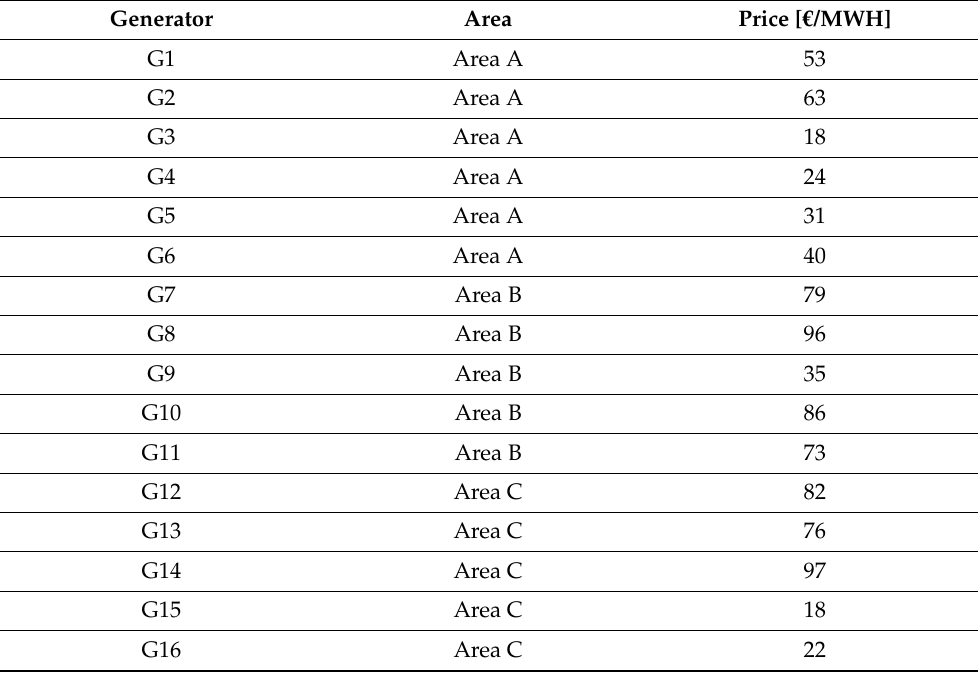
Table 1. Generator bids for the PST 16-machine test system.